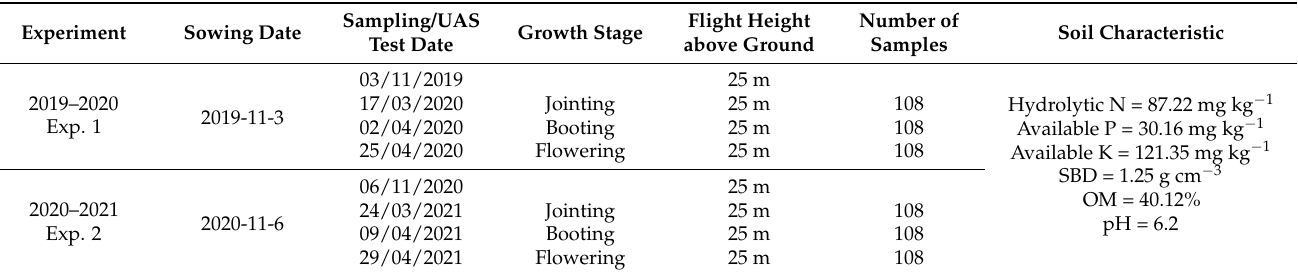
Table 1. Information on the field experiments.